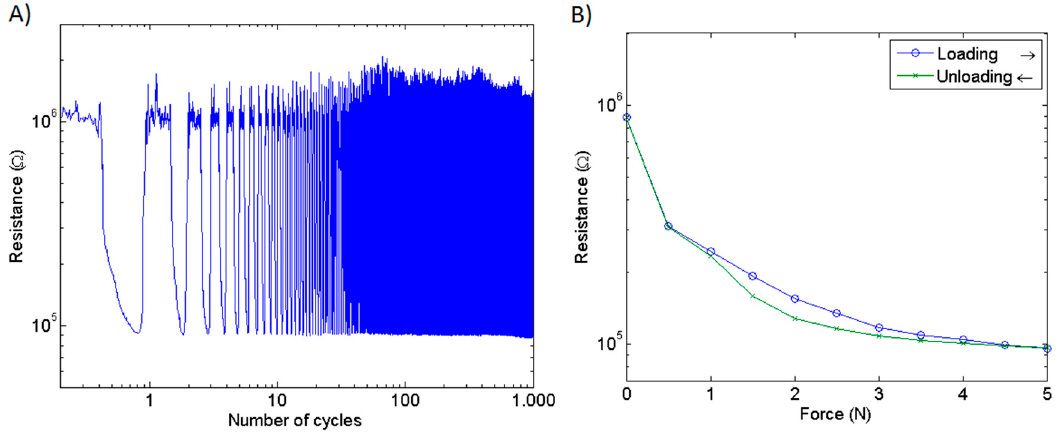
Figure 7. ( A ) Typical response of a single sensel of the mat prototype to the applied pressure. Error bars represent the standard deviation for three independent measures; and ( B ) boxplot that summarizes the response of 16 different sensels of the mat prototype.